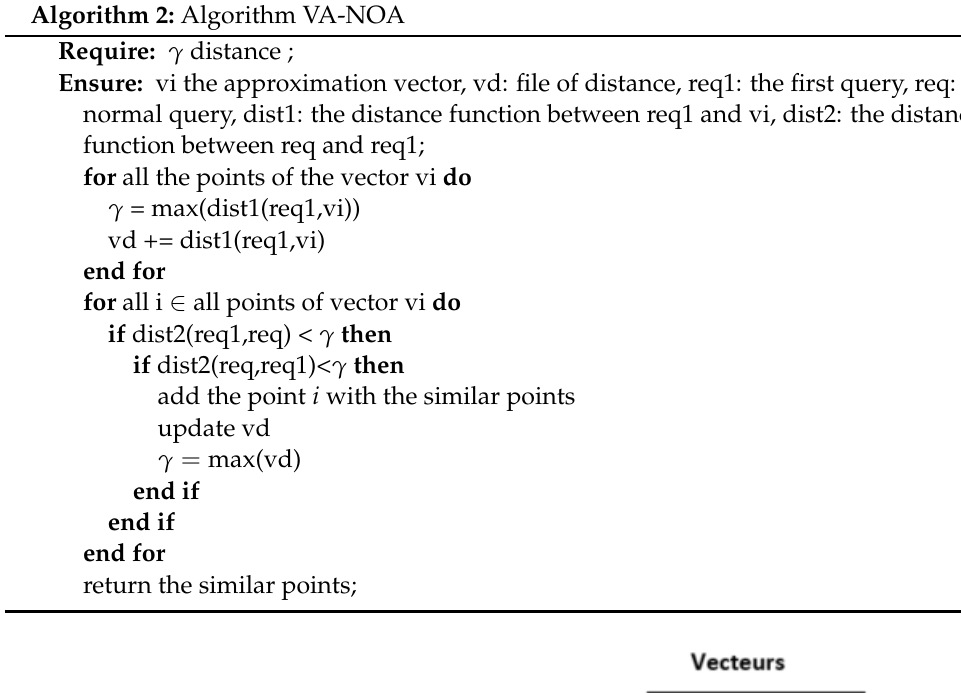
Algorithm 2: Algorithm VA-NOA